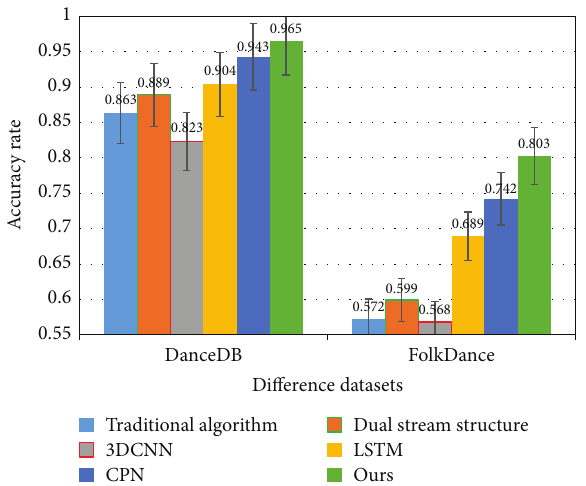
Figure 10: Comparison of the recognition accuracy of the algorithm in this paper on the two data sets.